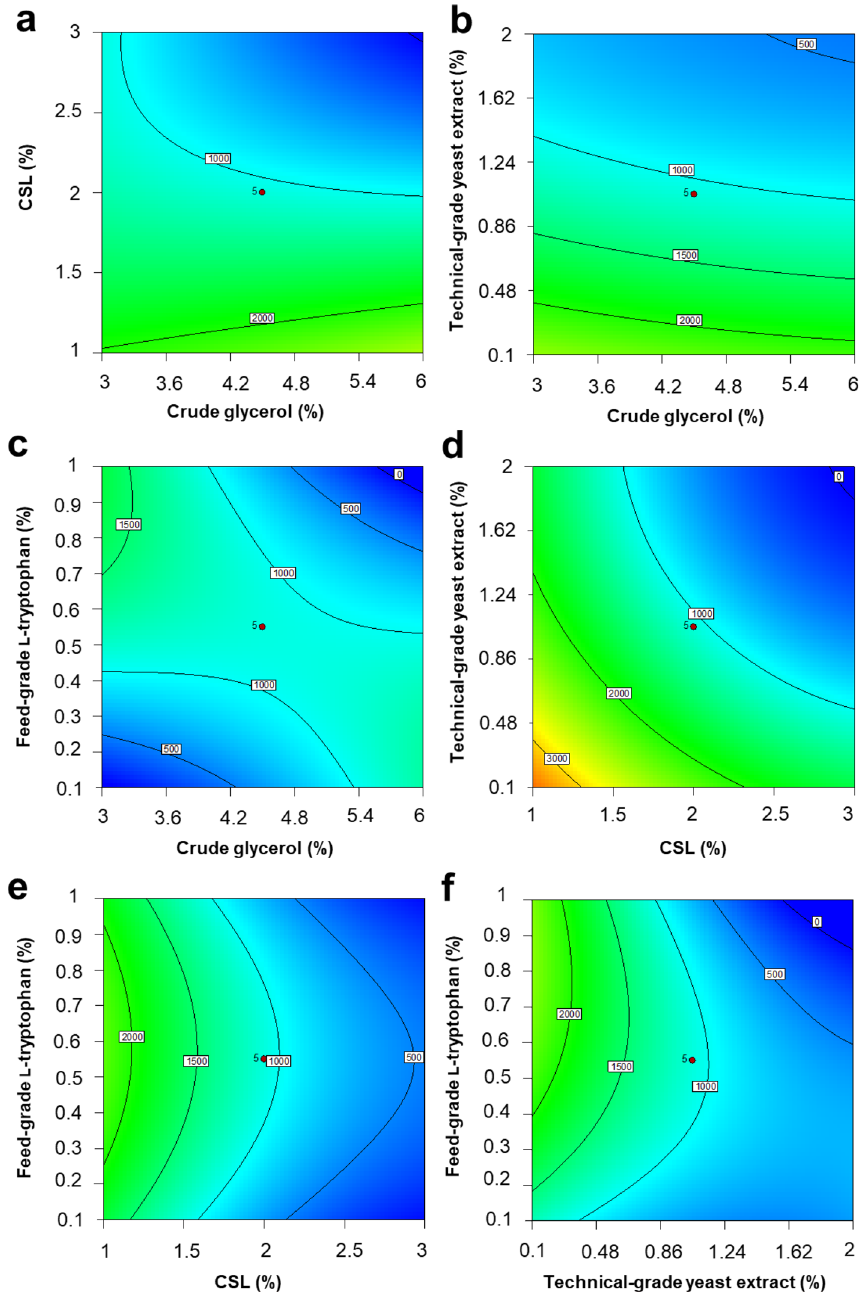
Figure 4. Contour plots of IAA production by the yeast R. fluvialis DMKU-CP293 using central composite design showing interactions between crude glycerol, CSL, technical-grade yeast extract, and feed-grade l-tryptophan after 5 days of incubation at 200 rpm and 34